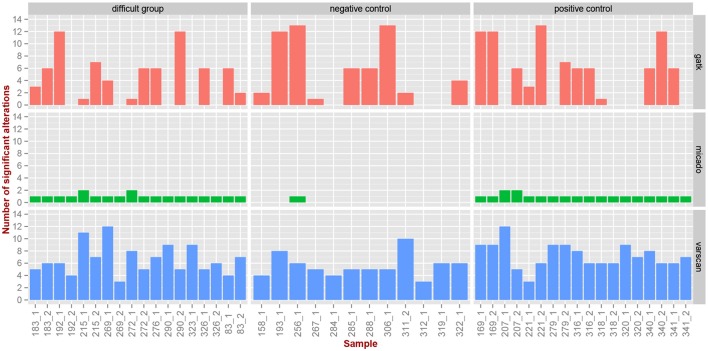
Comparison of caller's results for TP53 samples. Three pipelines (vertical panels) were applied on the TP53 samples (x-axis) to identify alterations in the three groups (horizontal panels). We report here the number of identified significant alterations (y-axis) per category (vertical panels) and per sample.